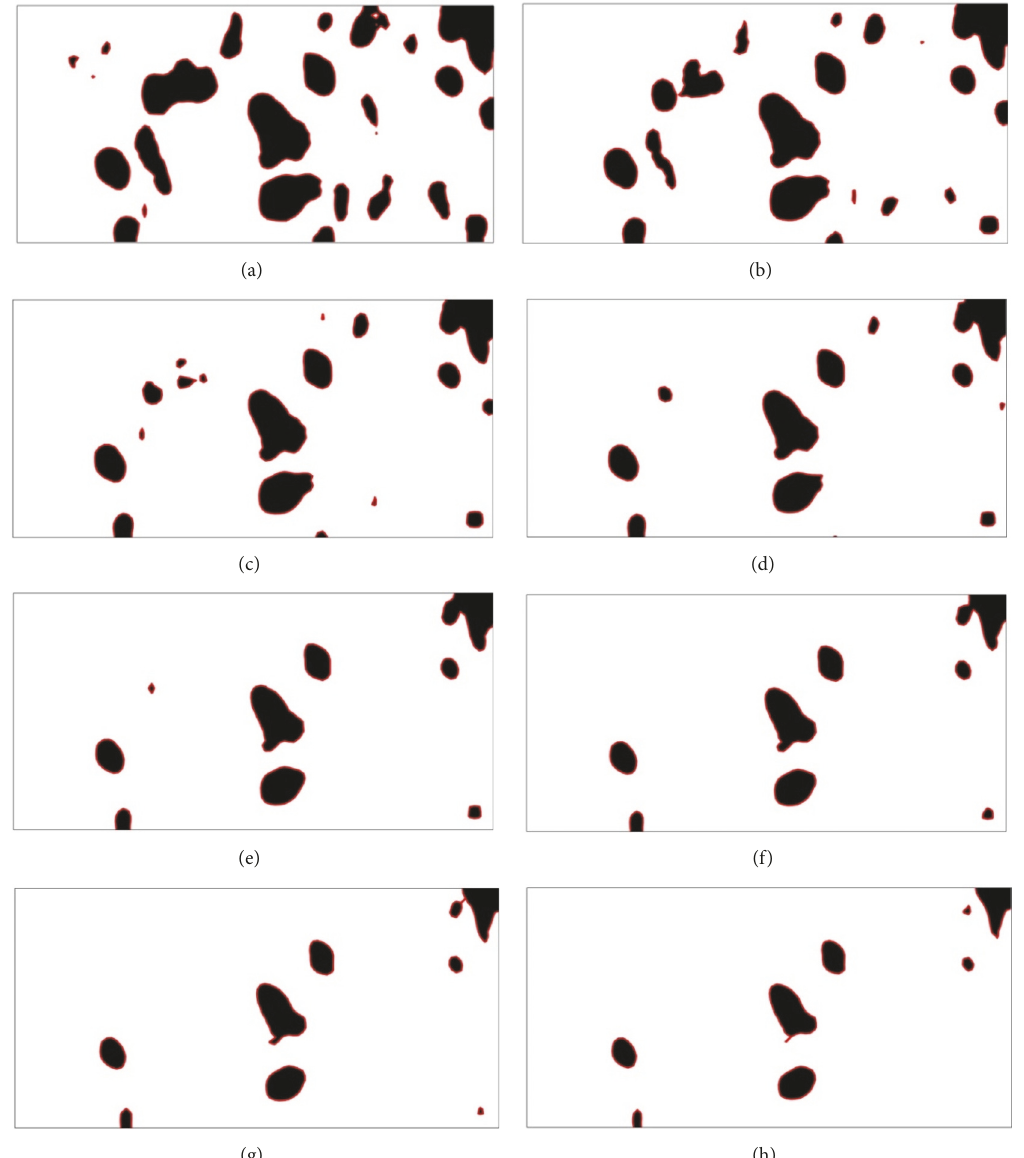
Figure 4: Black and white version of images in Figure 3 adapted to the Lacunarity analysis requirement.